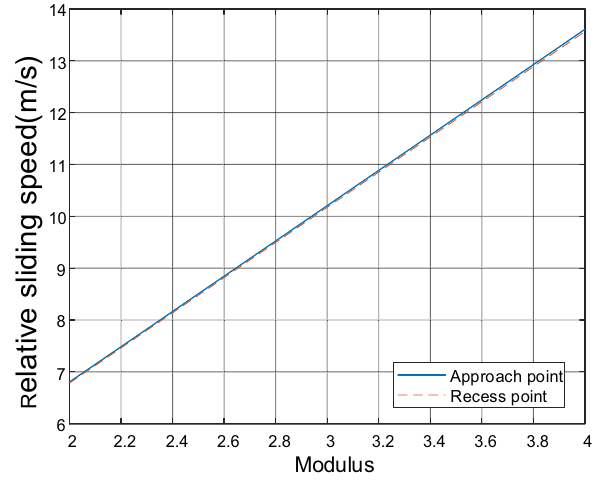
Fig. 8 Influence of helix angle on transmission efficiency